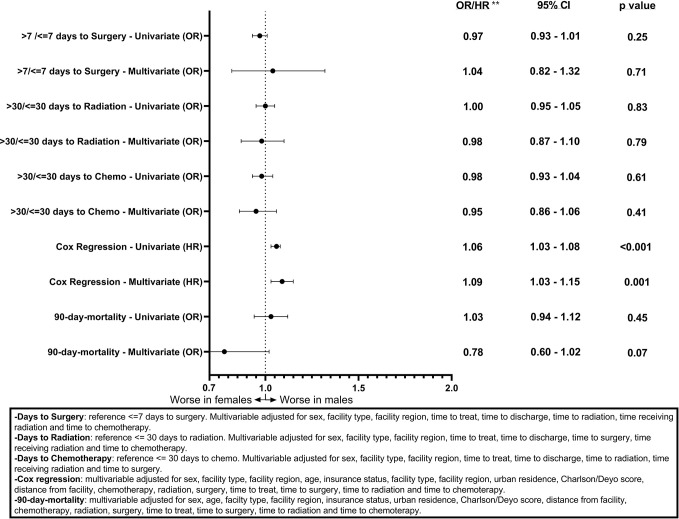
Forest plot of sex differences in clinical outcomes for LGG, National Cancer Database (NCDB), 2004–2016. **Odds ratios from logistic regression for days to surgery, days to radiation, days to chemotherapy, and 90-day mortality and Hazard ratios from Cox regression for overall survival.